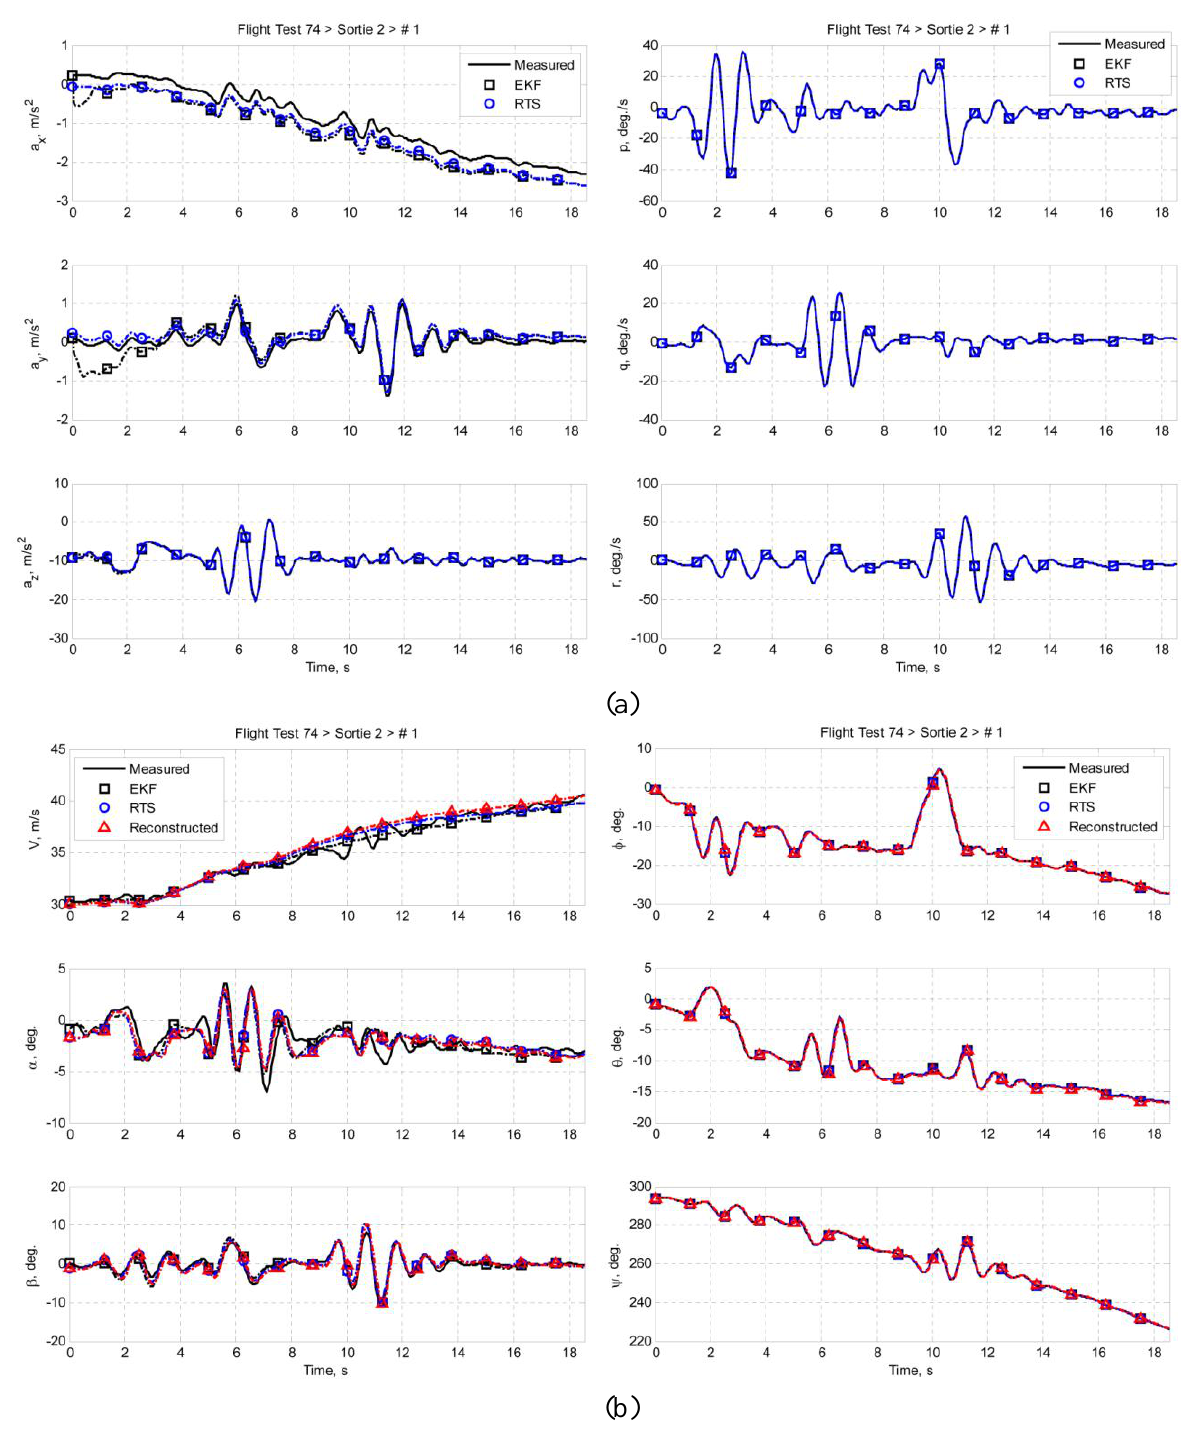
Figure 11. (a) Accelerations and angular rates of ft74srt02run01 before and after correction. (b) Airdata and attitude angles of ft74srt02run01 before and after